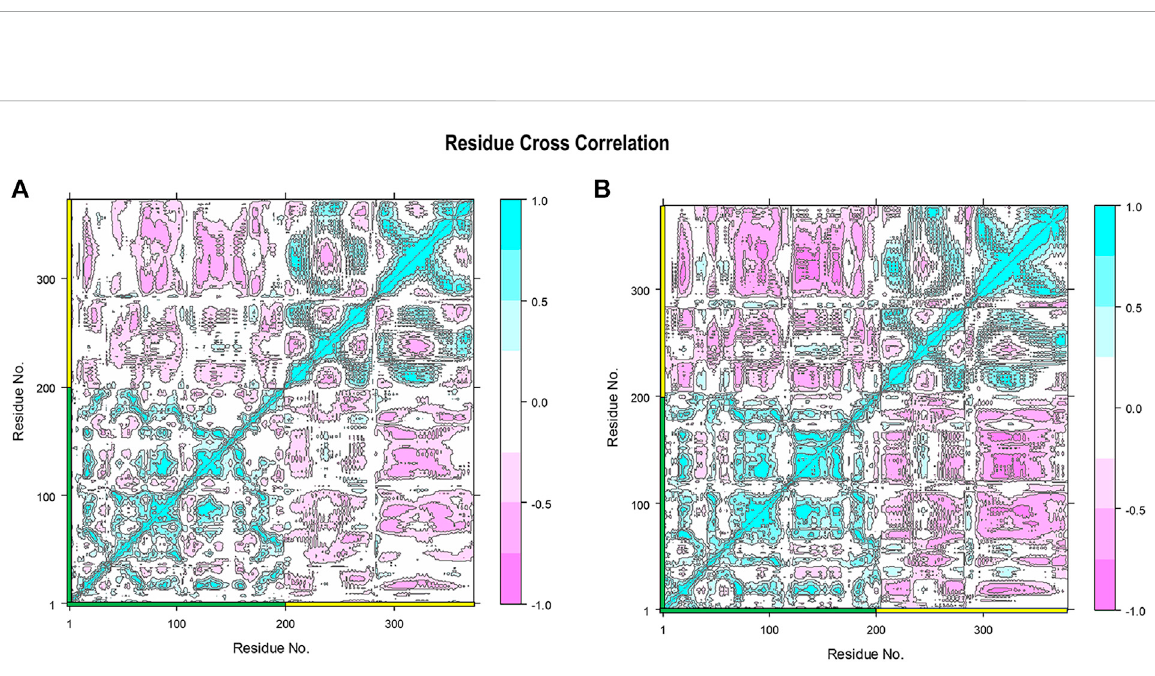
FIGURE 13 Residuecross-correlationmatrixofgRBDfNandgmRBDfNiscalculatedover100nsMDsimulationsforCAatoms.Shadesofredandbluespots presenttheatom ’ scorrelatedandanti-correlatedmotions,respectively.ThegRBDfNandgmRBDfNsystemsareshownin (A) and (B) .Theaminoacid residues of RBD and ferritin are marked on the x and y axes with green and yellow, respectively. The values of the correlations range from -1 to 1 as shown in the bar on the